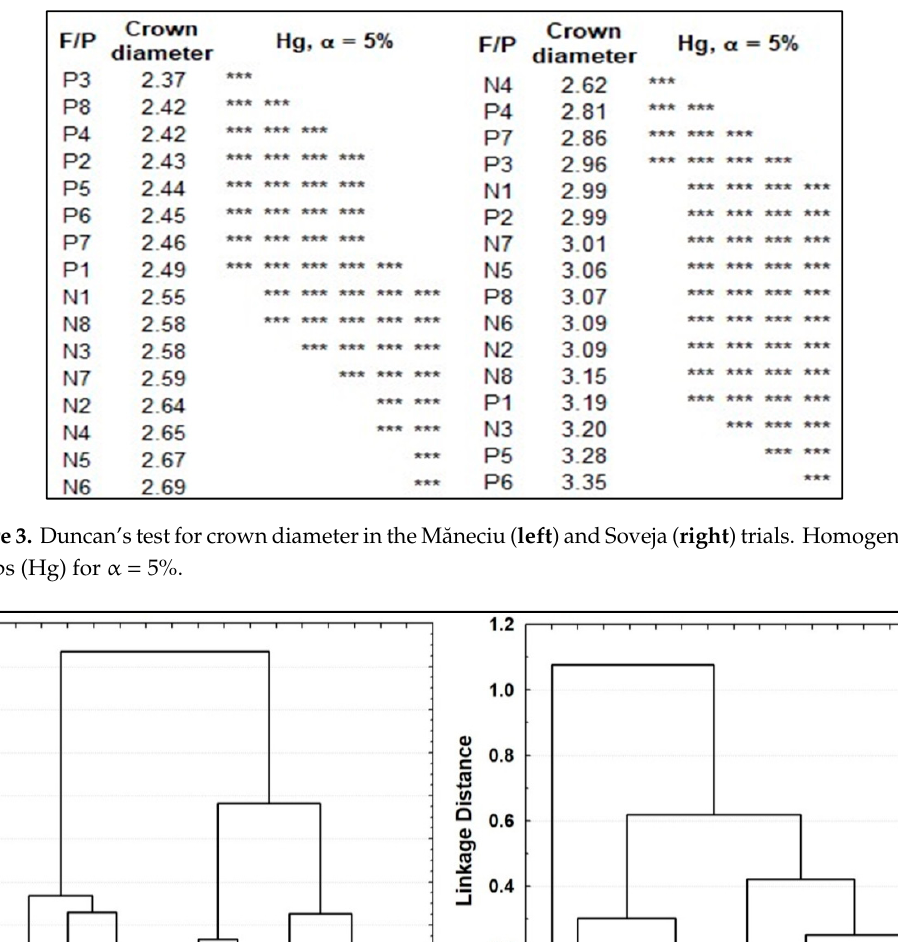
Figure 4. Cluster analysis for crown traits in the M ă neciu ( left ) and Soveja ( right ) trials. Diagram for crown traits, complete linkage, Euclidean distances.